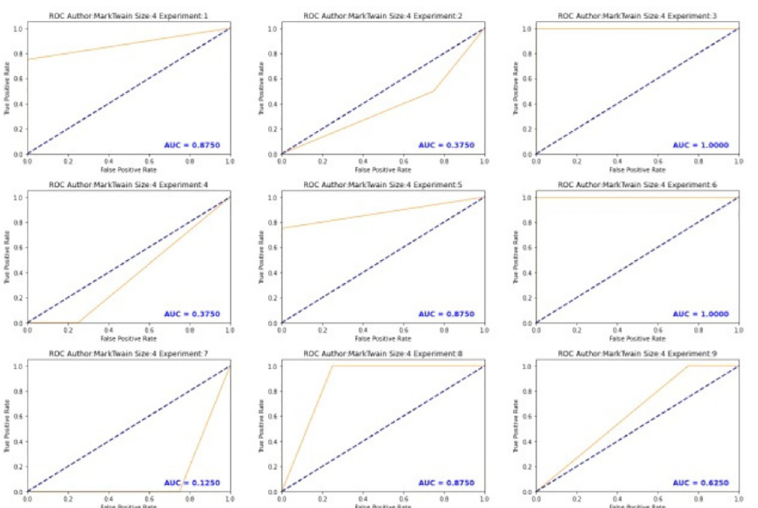
Fig 13. ROC of Mark Twain (MT) using syntactic relationship